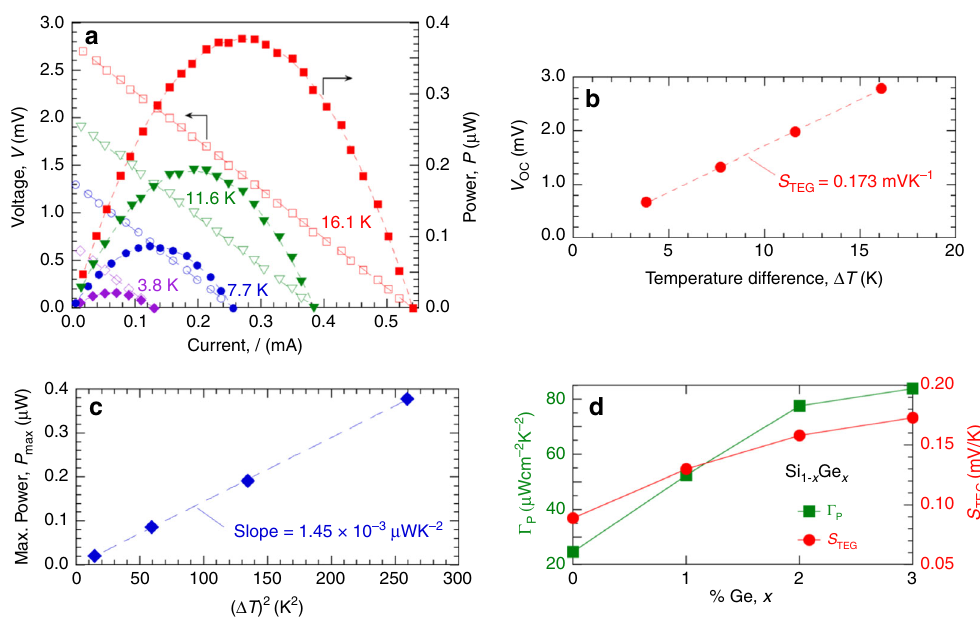
Fig. 1 Performance of test mode µ TEG with highest power density. a Power – current – voltage data with T C = 300 K and Δ T = 3.8 K (purple diamonds), 7.7 K (blue circles), 11.6 K (green triangles), and 16.1 K (red squares). Open symbols are voltage data (left axis) and fi lled symbols are power = V · I data (right axis). Dashed lines are linear (for I – V ) and quadratic (for I – P ) least-square fi ts to the data. b Open circuit voltage V OC vs. Δ T . The dashed line is a linear least-square fi t. c Maximum power, P max, as determined from the data in a , vs. ( Δ T ) 2 . The dashed line is a linear least-square fi t. d Speci fi c power density, Γ P (green squares, left axis) and TEG device Seebeck coef fi cient, S TEG (red circles, right axis) vs. Ge percentage x for four µ TEGs having the same device layout as the one represented in a . The solid lines simply connect data the V and I axes, respectively. The generated power P = VI has